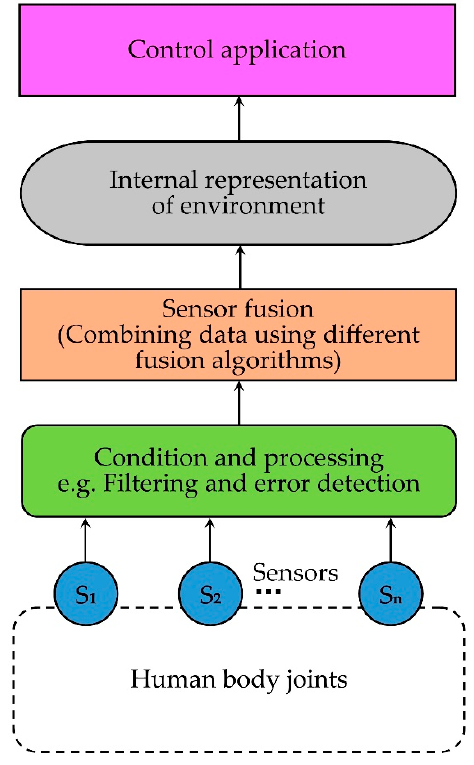
Figure 13. A simplified block diagram of sensor fusion methods.